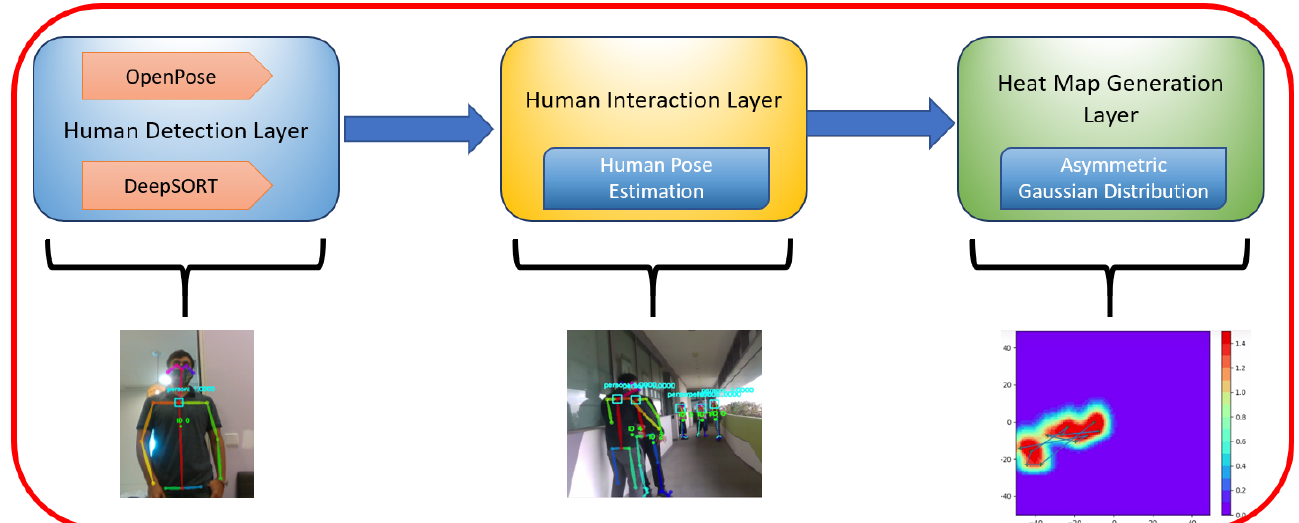
Figure 6. The block diagram of the vision-based framework for safe social distance